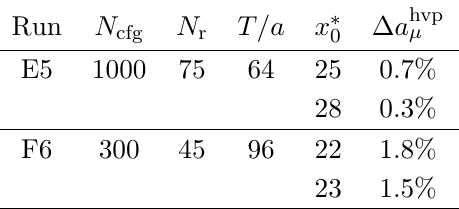
Table 12 . Details of the evaluation of quark-disconnected contribution G disc ( x 0 ) (see eq. (D.3)). N r denotes the number of stochastic sources per timeslice, while x (cid:3) represents the Euclidean time 0 at which the ratio G disc ( x 0 ) =C (cid:26)(cid:26) ( x 0 ) is replaced by its asymptotic value. The upper bound on the size of the quark-disconnected contribution to a hvp (cid:22)